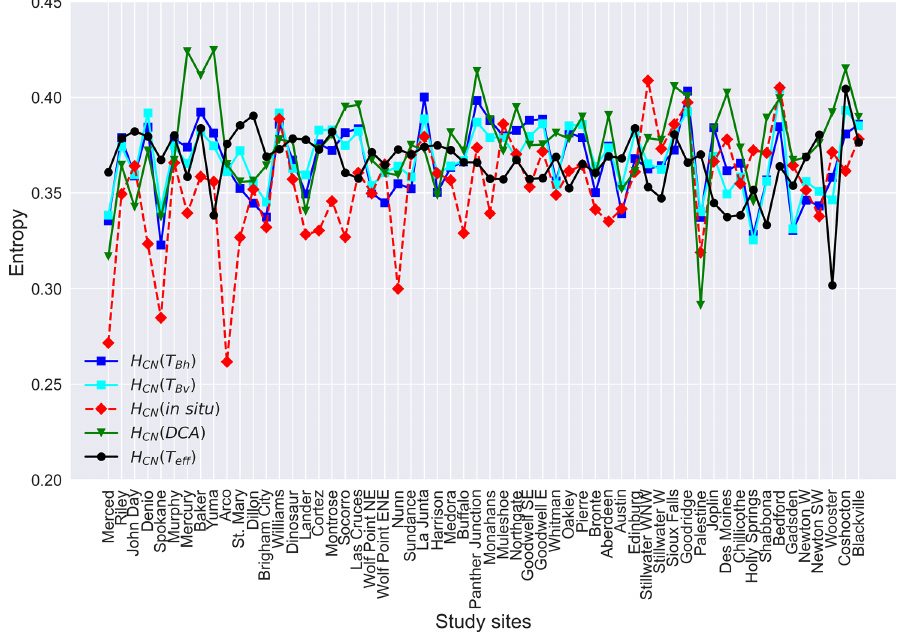
Figure 2. Entropies of horizontally polarized brightness temperature ( T Bh ), vertically polarized brightness temperature ( T Bv ), in situ soil moisture, DCA soil moisture, and soil effective temperature ( T eff ) across the study sites. The sites are ordered by longitude (west to east).